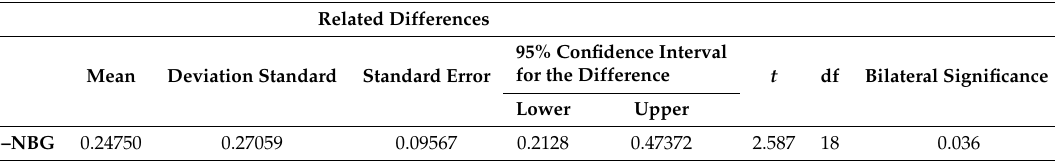
Table 8. Result of the Student’s t -test for the BG–NBG group.